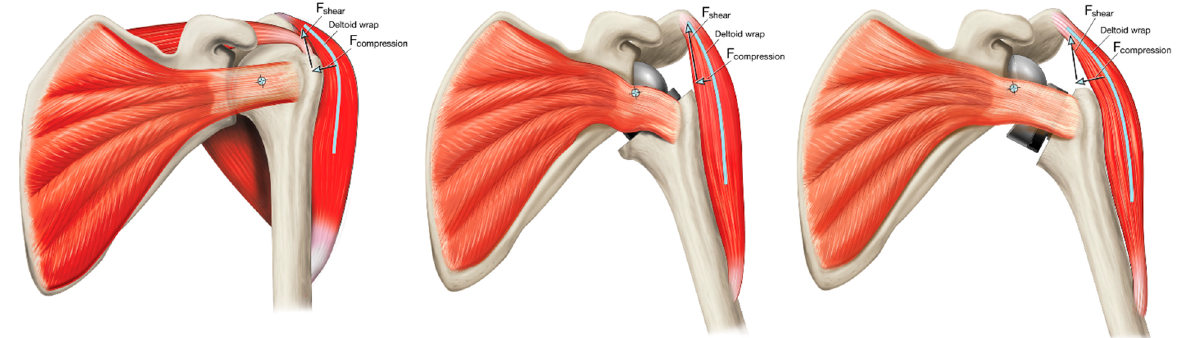
Figure 5. Wrapping of the middle deltoid around the lateral proximal humerus generates a stabilizing compressive force; where a greater amount of deltoid wrapping results in a larger compression vector that imparts greater joint stability: native shoulder ( left ), medial glenoid/medial humerus design ( middle ), and medial glenoid/lateral humerus design ( right ).